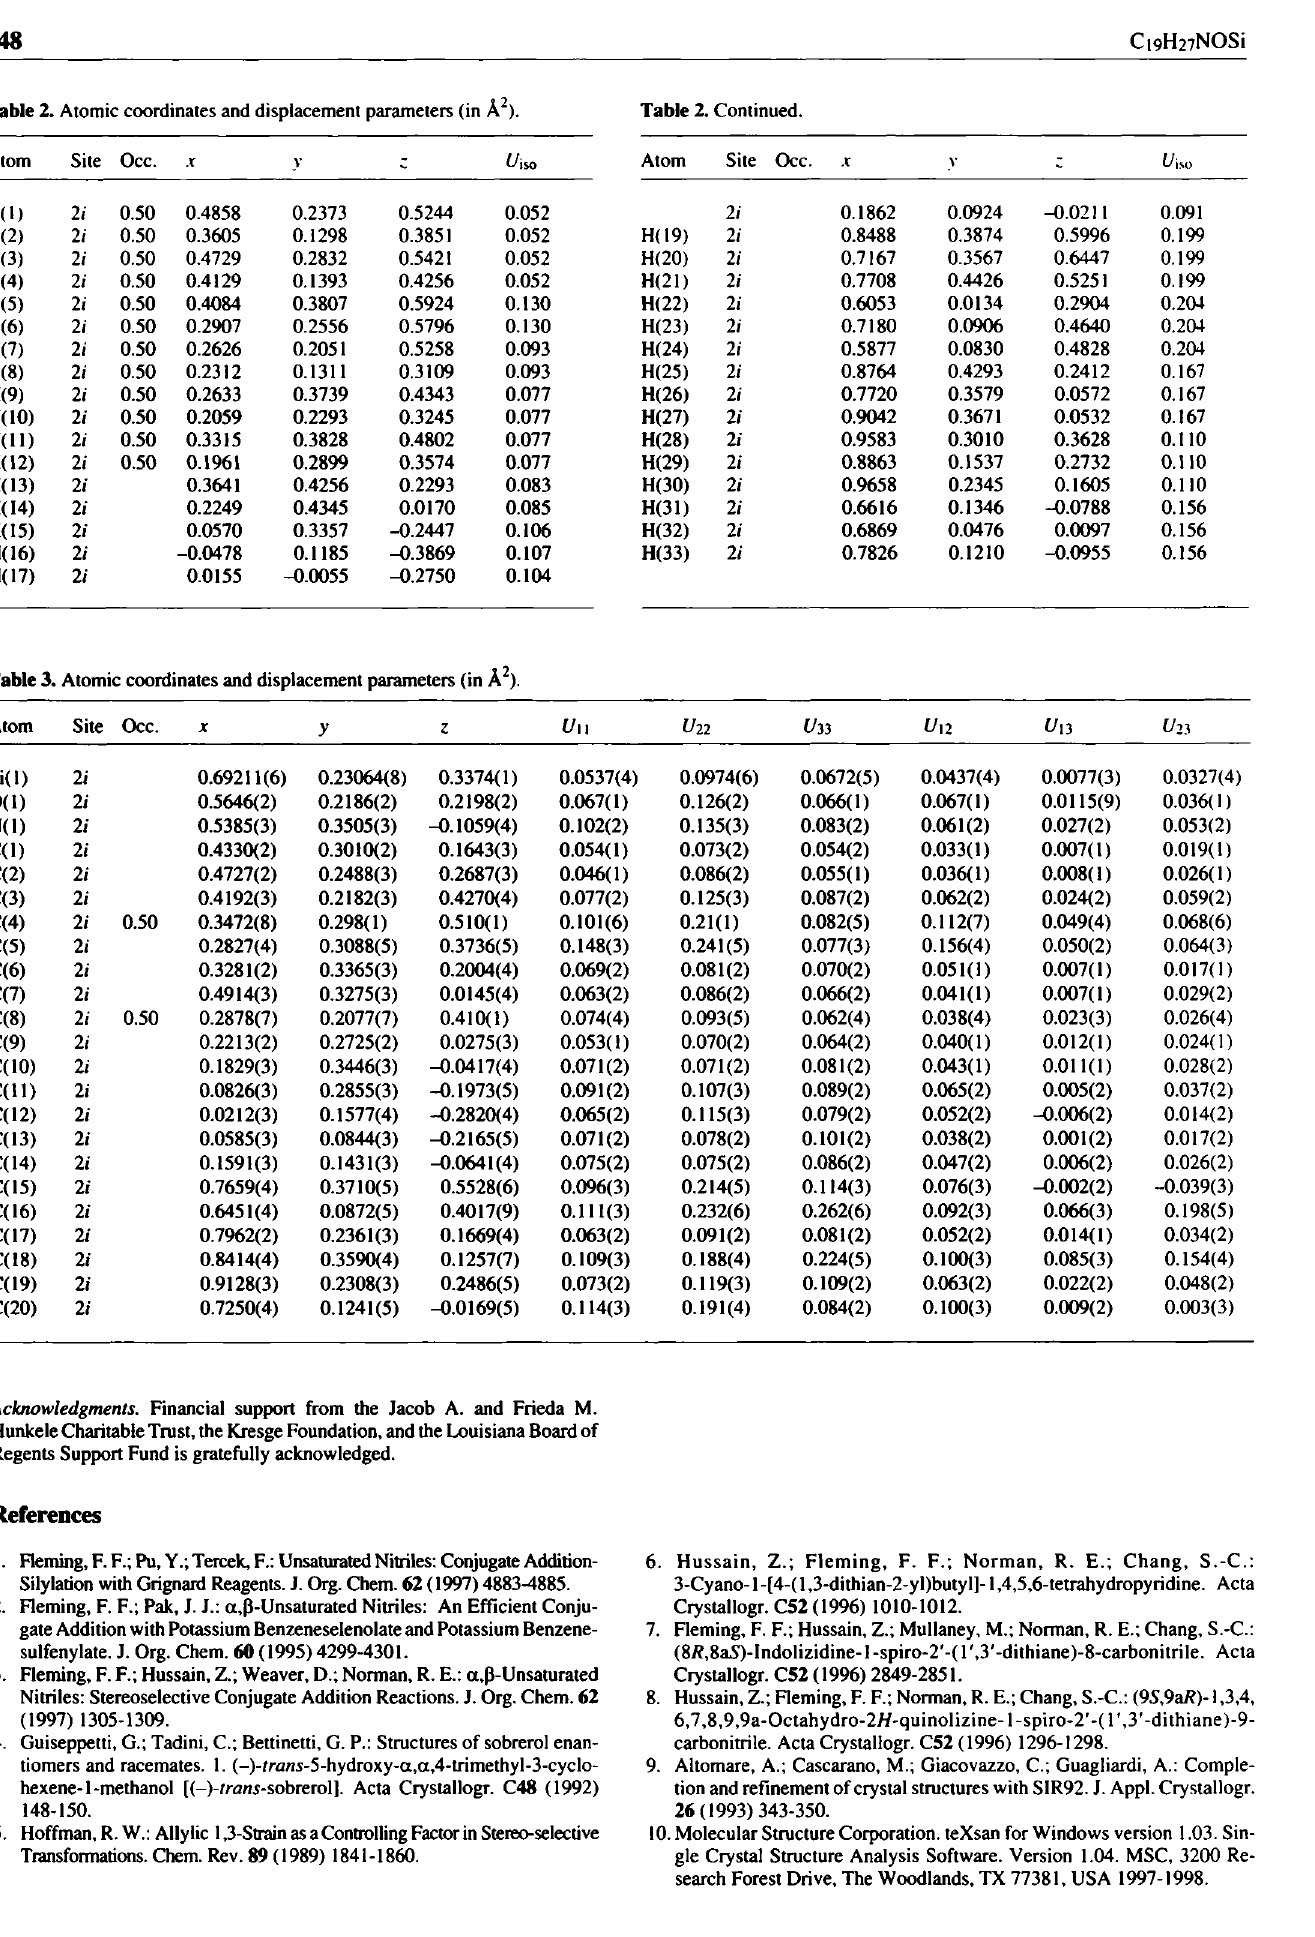
Table 3. Atomic coordinates and displacement parameters (in A 2